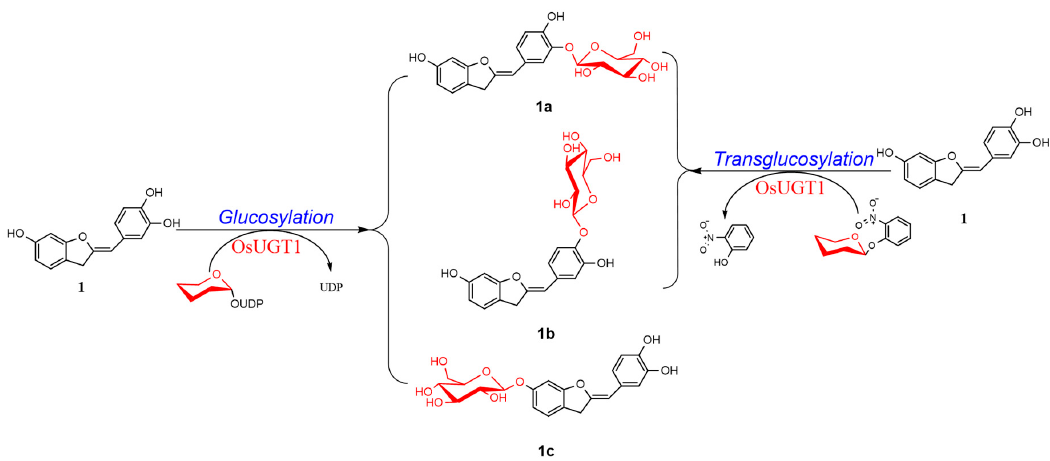
Figure 1. OsUGT1-catalyzed biosynthesis of sulfuretin glucosides ( 1a , 1b and 1c ) via glucosylation or transglucosylation reaction. UDP: uridine diphosphate; OsUGT1: glycosyltransferase from Ornithogalum saundersiae .